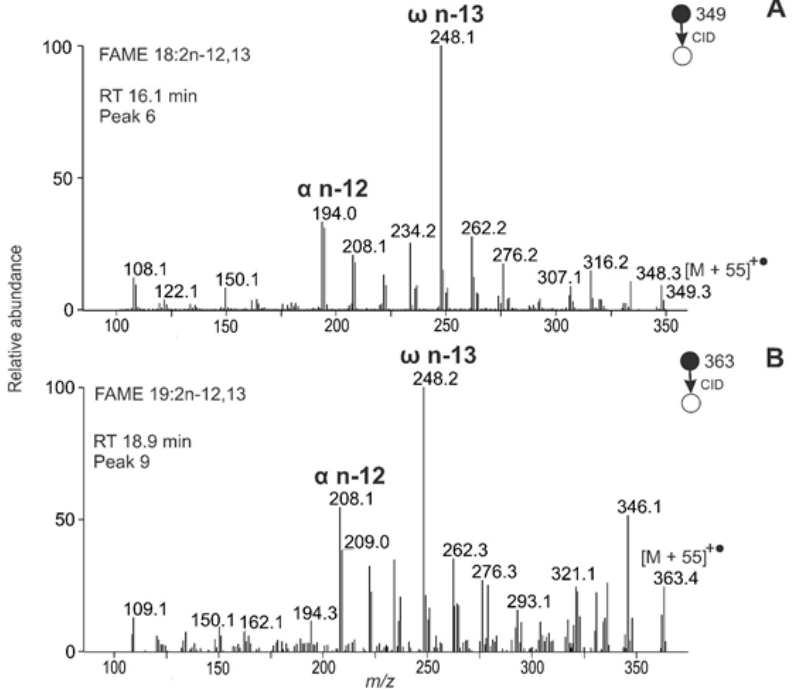
Figure 10. APCI MS/MS spectra of the [M + 55] + • adducts of allenic FAMEs from Marrubium vulgare seeds interpreted as FAME 18:2n-12,13 ( A ) and 19:2n-12,13 ( B ).